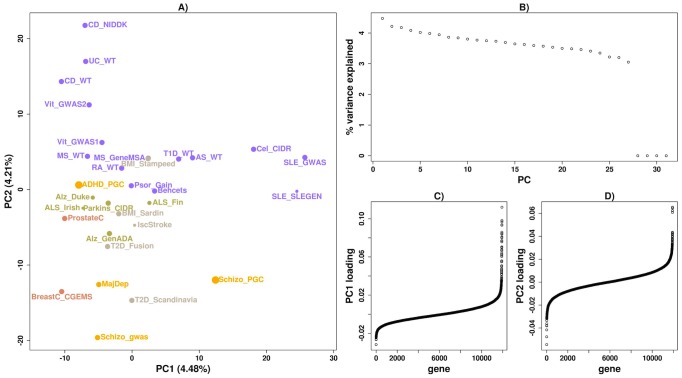

disPCA of all diseases and traits.A) Autoimmune diseases (purple), cancers (pink), psychiatric disorders (yellow), neurological disorders (green), and other diseases and traits (grey) are shown on PC1 and PC2. PC1 accounts for 4.48% of the variance, while PC2 accounts for 4.21%. Additional diseases include Alzheimer's disease (Alz), amyotrophic lateral sclerosis (ALS), ankyolosing spondylitis (AS), attention deficit hyperactivity disorder (ADHD), Behcet's disease (Behcets), body mass index (BMI), breast cancer (BreastC), celiac disease (CeliacD), ischemic stroke (IscStroke), major depression (MajDep), Parkinson's disease (Parkin), prostate cancer (ProstateC), psoriasis (Psor), rheumatoid arthritis (RA), type-1 diabetes (T1D), type-2 diabetes (T2D), ulcerative colitis (UC). PC1 clusters celiac disease and SLE together, while PC2 separates inflammatory bowel diseases from other diseases and traits. B) The portion of variance explained by each PC is displayed. Three additional PCs explain 0% of the variance corresponding to the number of confounders we accounted for (Materials and Methods). C) The weightings for genes on PC1 are displayed and ordered according to their weights. D) Similar to (C) where loadings are for PC2.